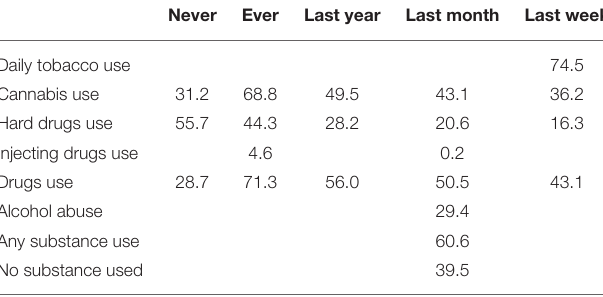
TABLE 5 | Substance use patterns (in %).